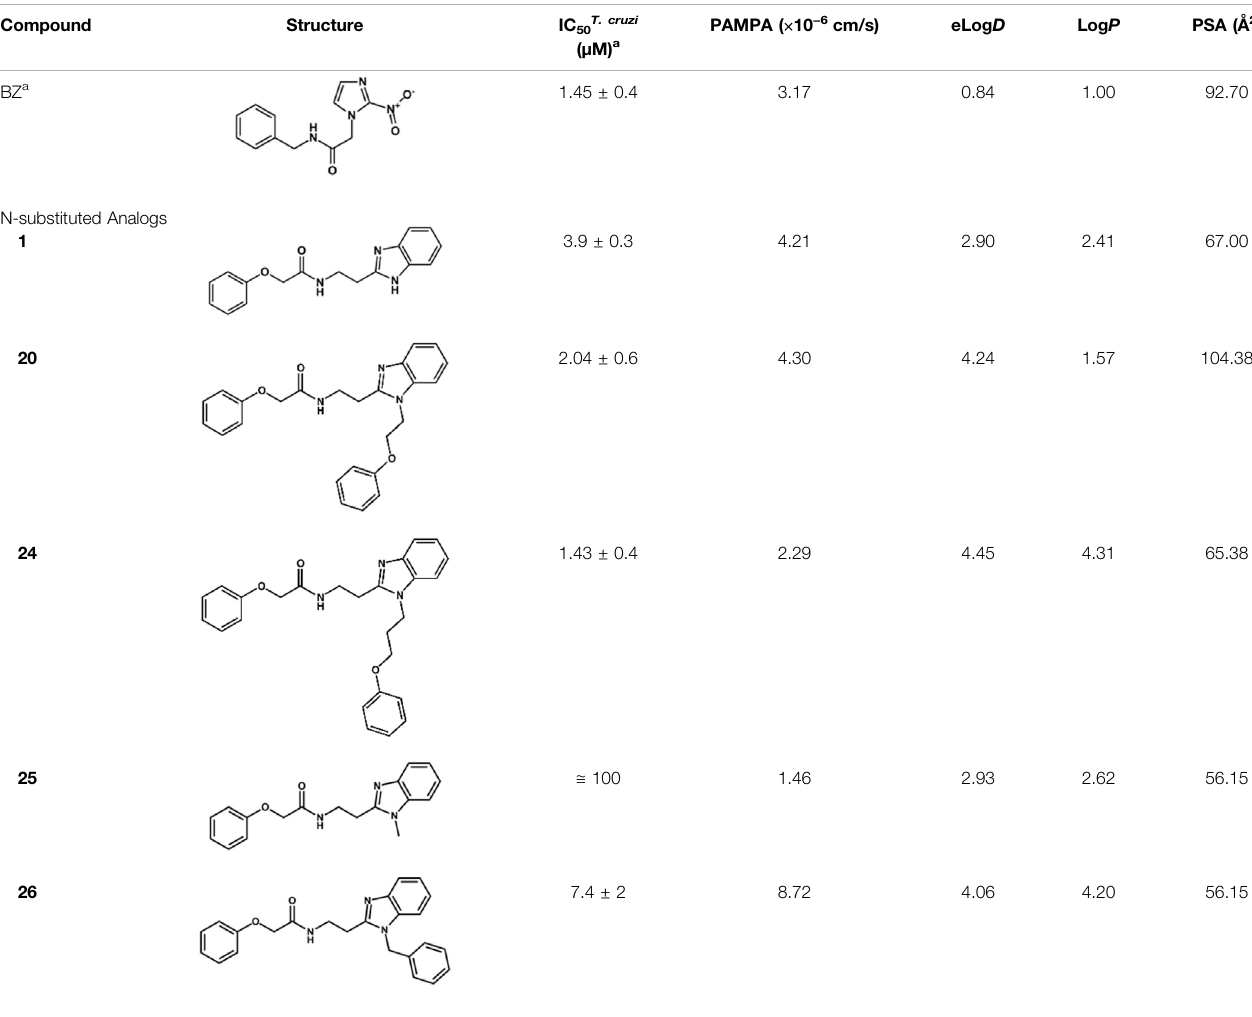
TABLE 3 | In vitro activity against T. cruzi and physicochemical properties of a subset of the benzimidazoles.